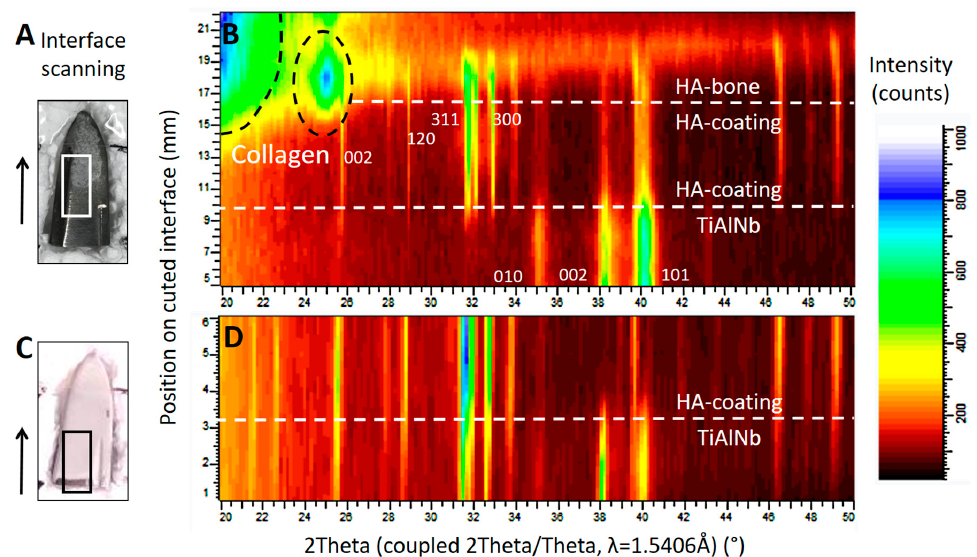
Figure 7. X-ray di ff raction studies on the implant surfaces, in ( B ) the results corresponding to the area marked by a white rectangle from the tip of the retrieved stem in ( A ), and in ( D ) the results corresponding to the area marked by a black rectangle from the tip of a new, unused stem in ( C ). The scan was performed in the area of interest, following the direction marked by the arrow. The corresponding position may be read from the y -axis in ( B ) and ( D ). Both diffraction patterns ( B ) and ( D ) show the successive change from the TiAlNb of the stems’ metal alloy to the HA phase of the coating. The scan progresses horizontally on a slightly oblique cut. In ( B ), structures from the ongrown bone can be seen on top of the HA coating. (---white) shows the phase change related to the position on the sample, and dashed black lines show the phase information retrieved from the organic material such as collagen. The main diffraction peaks of the TiAlNb and HA crystallographic phases (hkl) are marked by the corresponding hkl values.